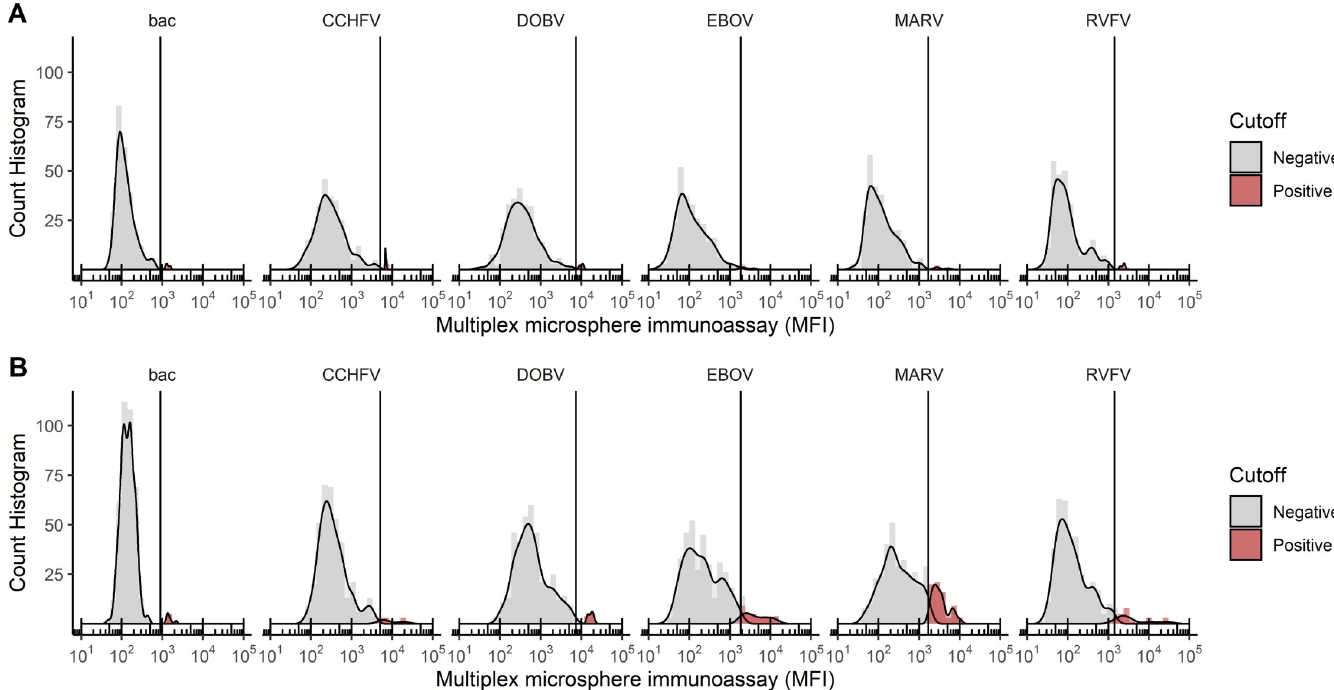
Fig 2. Histograms displaying the results of the MMIA for each viral NP. The x-axis displays the average MFI value for each serum sample tested in triplicate and the y-axis displays the number of serum samples that resulted in each MFI value. The serum panel from the (A) German blood bank and (B) from Guinea are shown individually. A conservative cutoff value is indicated by a vertical line on each plot, and was chosen based on the 99th percentile for serum samples in the German blood bank panel. This is a population based cut-off and assumes that 99% of serum samples in the German blood bank are negative for the indicated virus. Samples were assigned a positive or negative status based on this cutoff, and in all cases, negative serum samples are shown in grey and positive serum samples are shown in red.